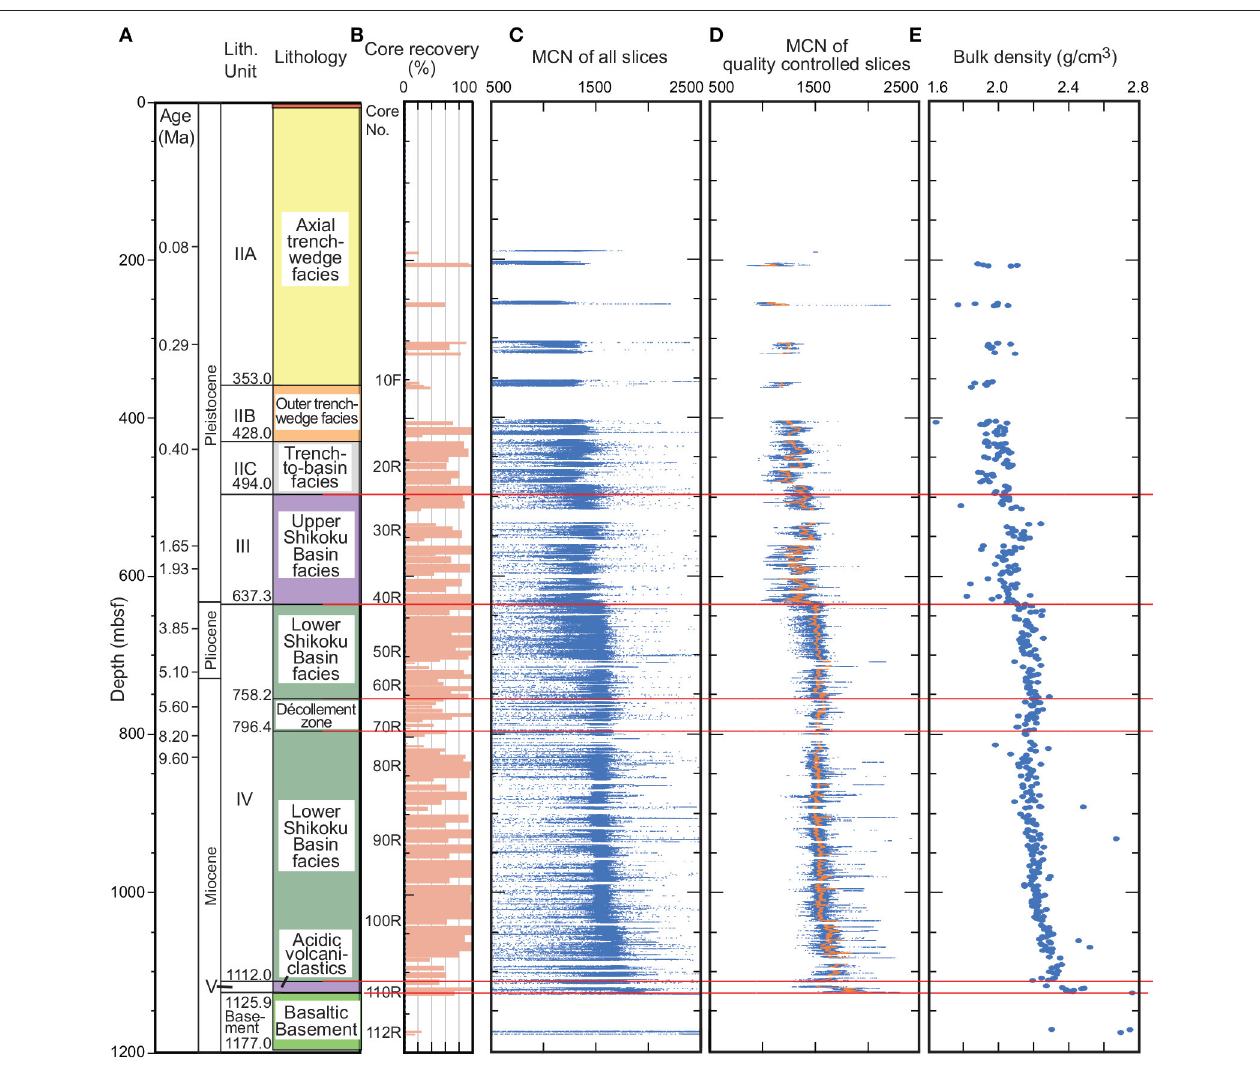
FIGURE 3 | Site summary diagram of X-ray CT scanning for Site C0023 from 0 to 1,200 mbsf. Original data are from Heuer et al. (2017b). (A) Lithological facies. (B) Core recovery. (C) Mean CT number (MCN) profile using all CT slices. (D) Quality-controlled MCN profile. Orange plots are 500-slices moving averages of MCN. (E) Bulk density. mbsf, meter below sea floor; Lith. Unit, Lithological